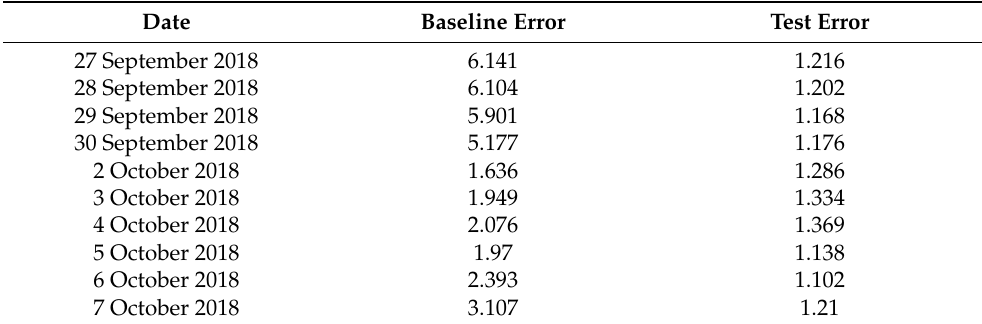
Table 3. Errors on the entire test set of the 10-parameter model by 1 h granularity on 1 October 2018 (Model 2).